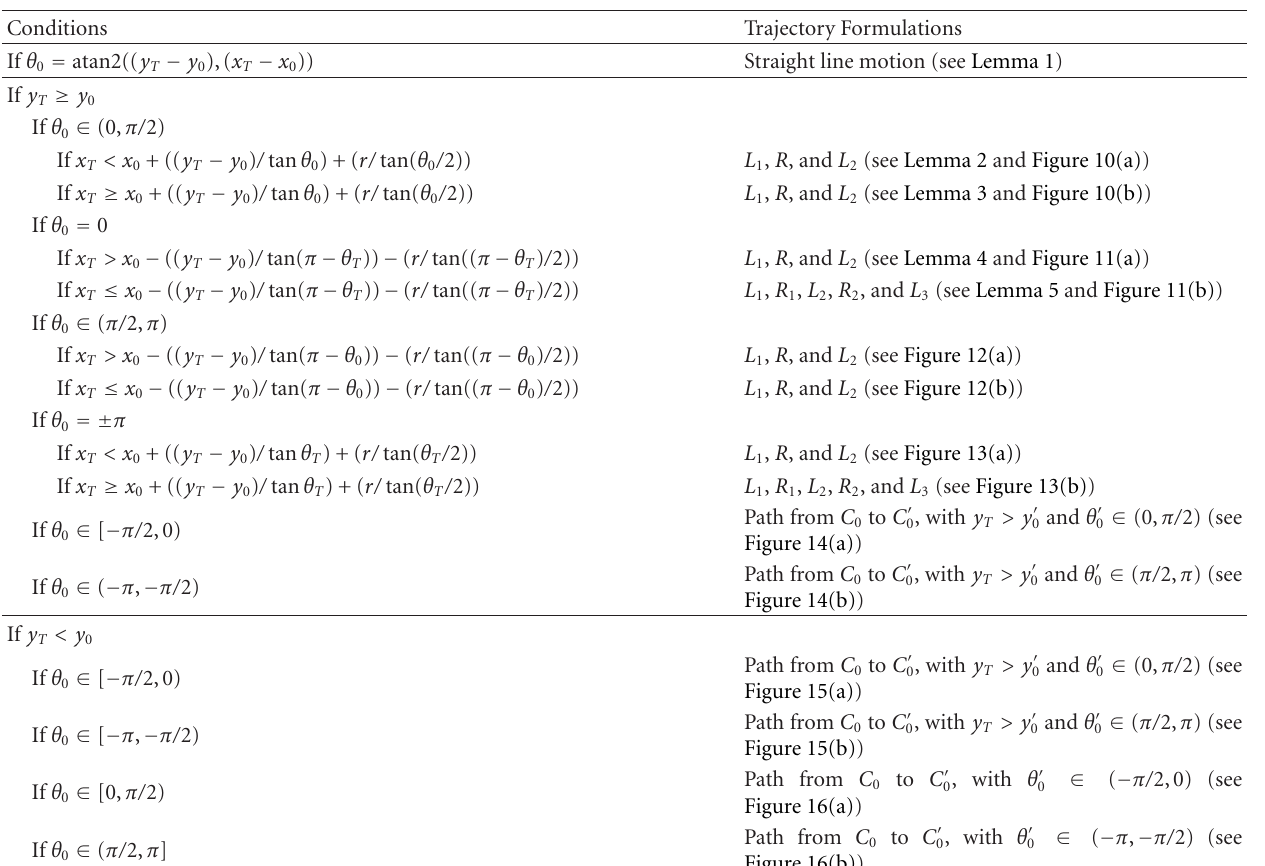
Table 1: Classification of wearing